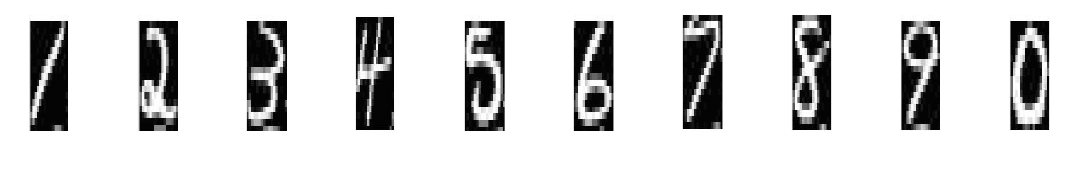
Figure 2. Illustration of 10 digits in the USPS dataset.